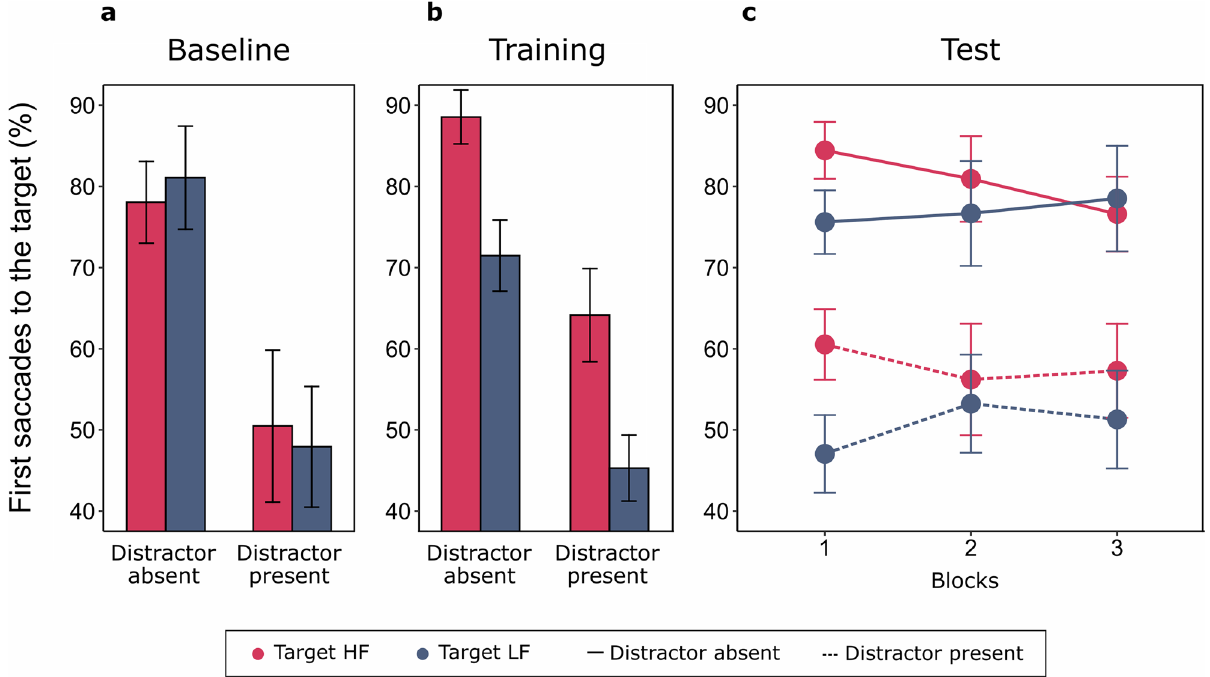
Figure 5. Mean percentages of target-directed saccades as a function of Target and Distractor conditions in Experiment 3. ( a ) Performance at baseline. ( b ) Performance at training. ( c ) Performance at